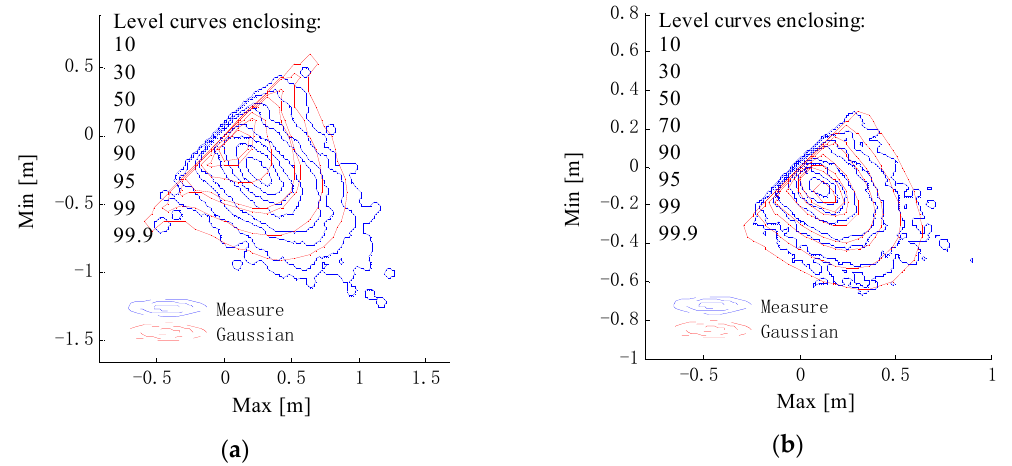
Figure 15. Joint density maxima and minima of the measured data and the Gaussian model for ( a ) H s = 1.0583 m and ( b ) H s = 0.6069